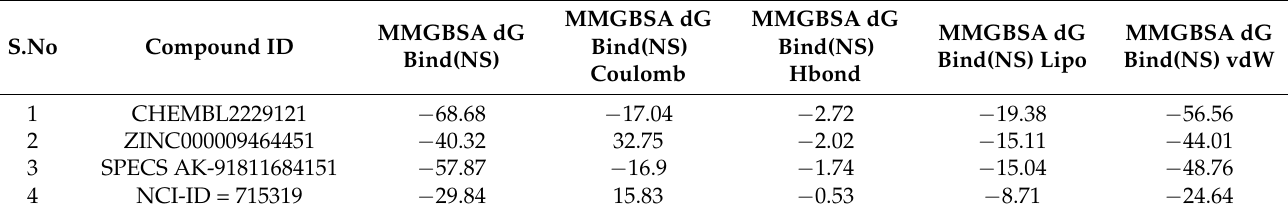
Table 7. MM-GBSA binding energies (kcal/mol) with ligand-receptor conformational changes not accounted for in energy